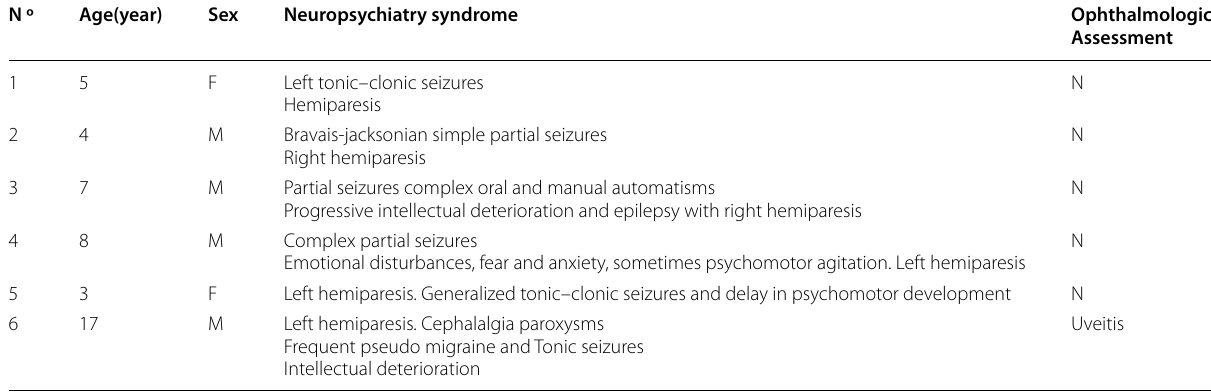
*M: Male; F: Female; N: Normal